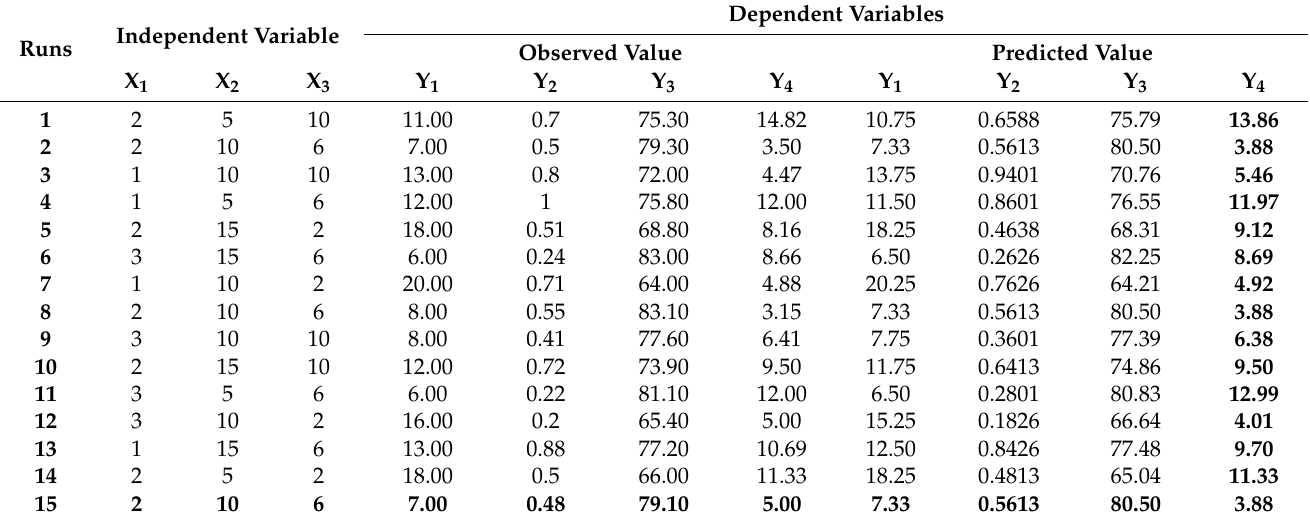
Table 3. Design (Box–Behnken) of experiments with results.